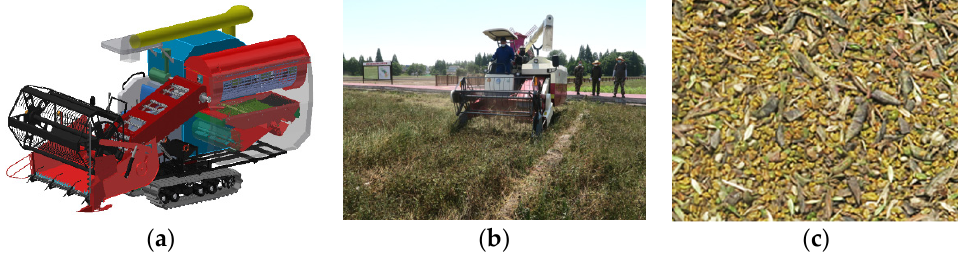
Figure 9. Combined Chinese milk vetch seed harvester and field test process. ( a ) Three-dimensional diagram of the combined Chinese milk vetch seed harvester. ( b ) Chinese milk vetch field harvest test. ( c ) Materials in the seed bin.